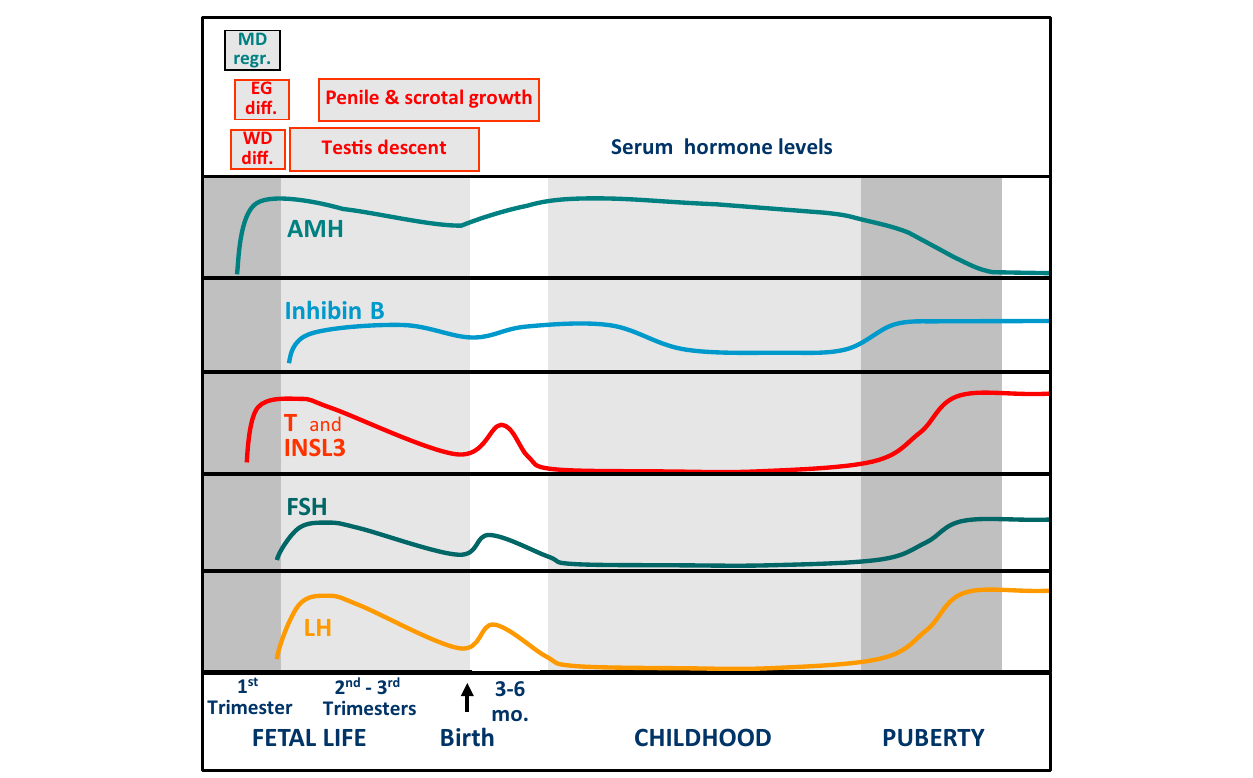
FIGURE 1 | Schematic representation of the pituitary–testicular axis hormone levels and of sexual differentiation and development of male internal and external genitalia .WD diff.,Wolffian duct differentiation; MD regr., Müllerian duct regression; EG diff., differentiation of the external genitalia.